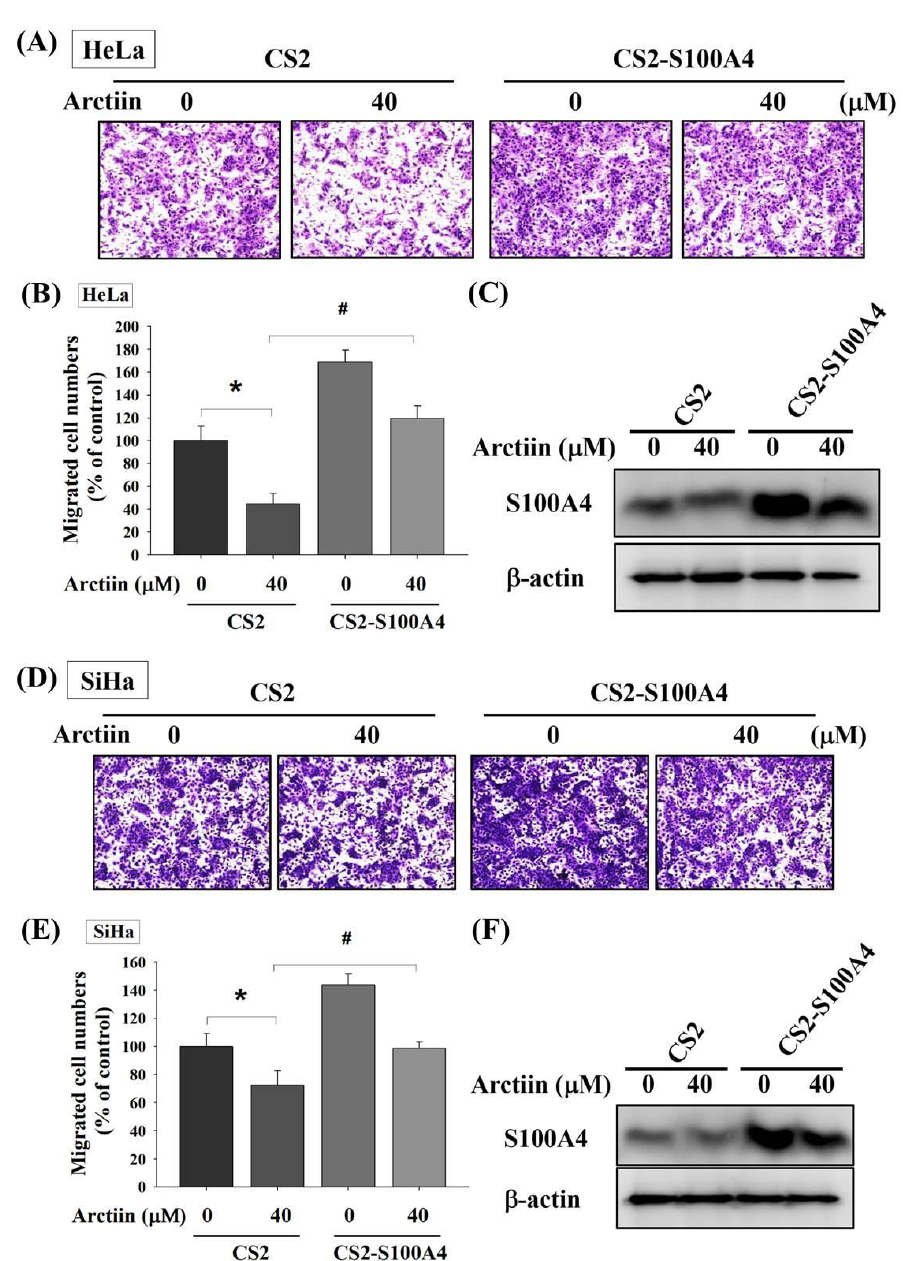
Figure 4. Effects of S100A4 on cell migration and invasion of HeLa and SiHa cells. ( A – C ) Cell migration assays and Western blot analyses for HeLa cells with or without arctiin treatment or overexpression of S100A4 (CS2-S100A4), were measured, respectively. ( D – F ) Cell migration assays and Western blot analyses for SiHa cells with or without arctiin treatment or overexpression of S100A4, were measured, respectively, and migratory cells were subsequently subjected to quantitative analysis. * p < 0.05, compared with the control group. # p < 0.05, comparison with the arctiin-treated group.